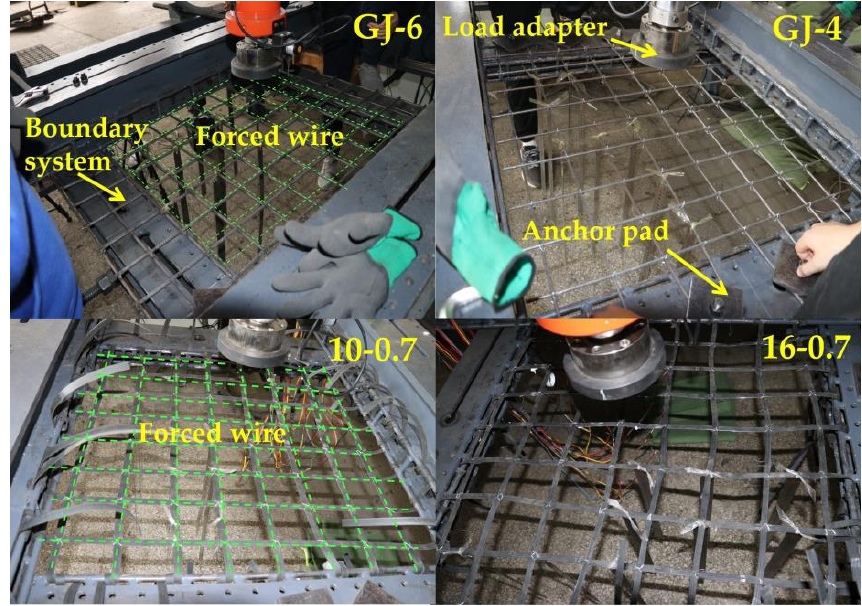
Figure 8. Partial specimen mounting.